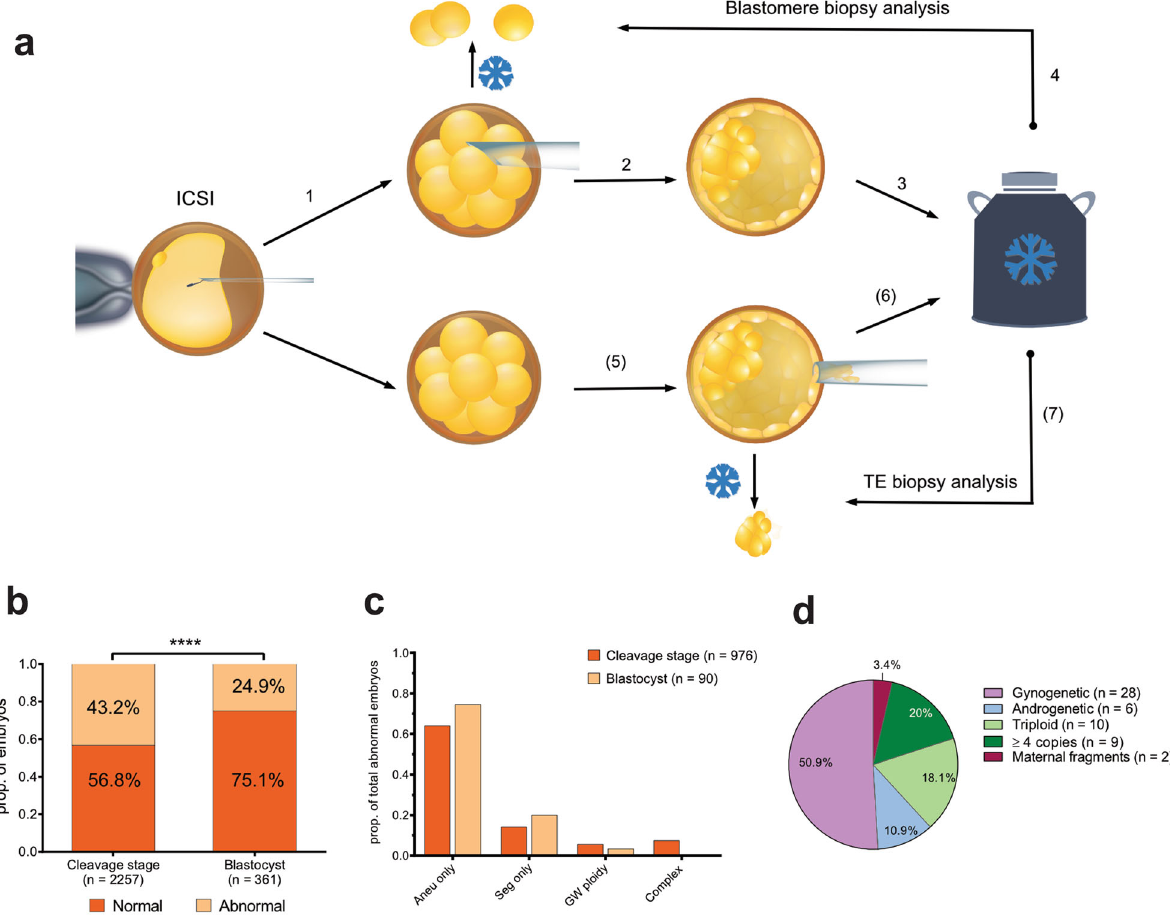
Fig. 1 Genomic landscape of cleavage stage embryos and blastocysts derived from PGT-M patients. a Following intracytoplasmic sperm injection (ICSI), one or two blastomeres are biopsied on day-3 (D3) (1). Following D3 biopsy, embryos are cultured further until blastocyst